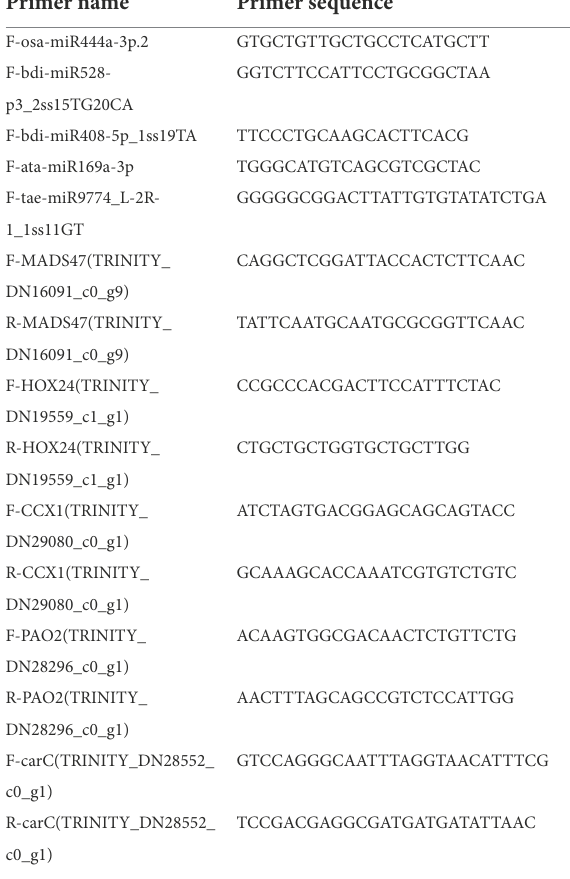
TABLE 1 A list of primers used for validation in RT-qPCR. RT-qPCR, quantitative reverse transcription PCR. Primer name